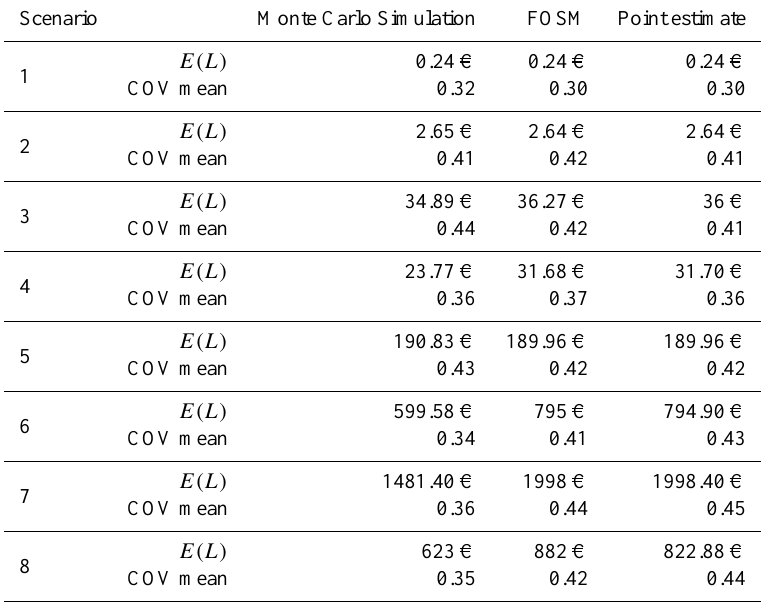
Table 8. Expected annual losses E(L) (Cyr − 1 ) and COV values for industrial scenarios. Comparison of the three methods: Monte-Carlo- Simulation, First Order Second Moment, and point estimate.